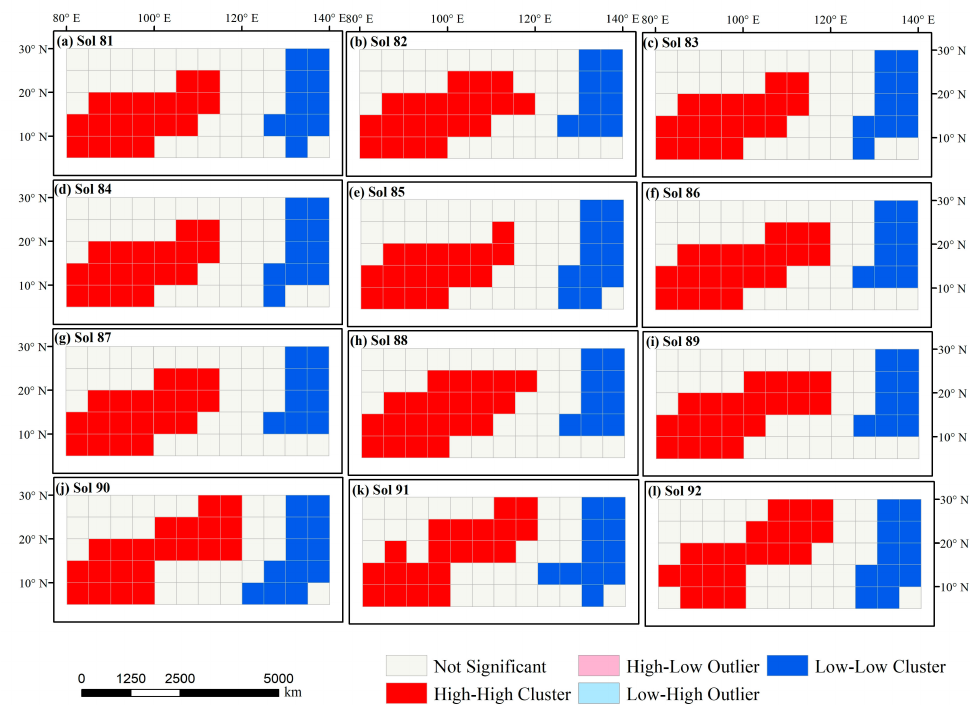
Figure 6. LISA map for sol average temperature (SAT) during sol 81–92 in Martian year 29. The LISA maps for SAT during sol 81–111 from Martian year 29 to 32 are provided in the Supplementary Materials (Figures S1A–D).